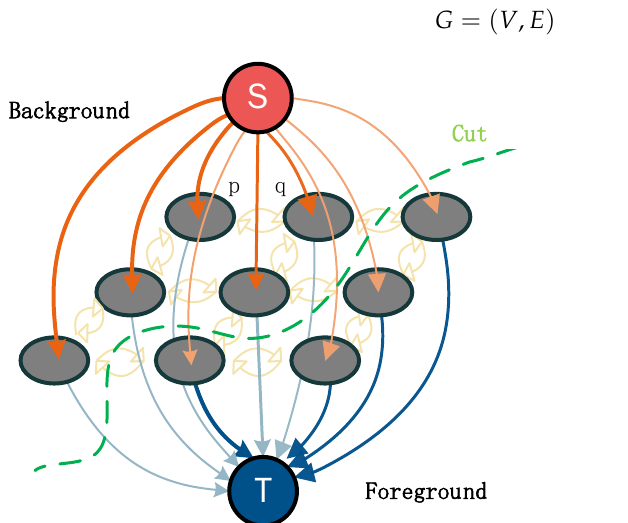
Figure 3. An example of graph cut segmentation for a simple 3 × 3 image (adapted from [36]).